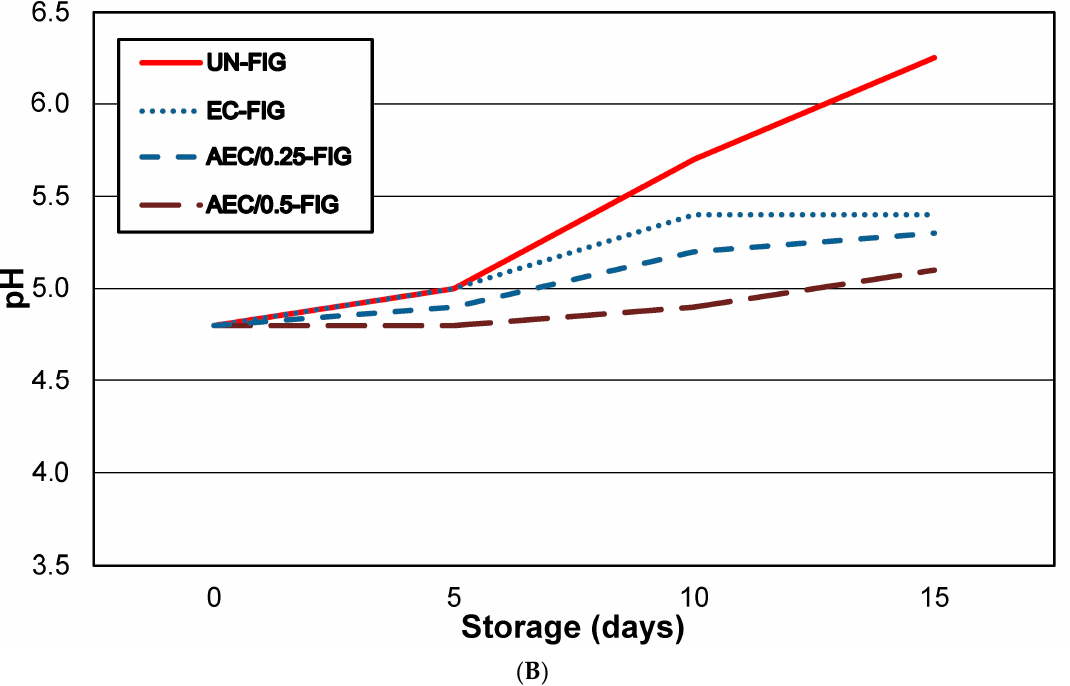
Figure 1. ( A ) Loss in weight (%) of fig fruits during storage at 4 °C for 15 days for all different preservation methods. ( B ) pH values of fig fruits during storage at 4 °C for 15 days for all different preservation methods.